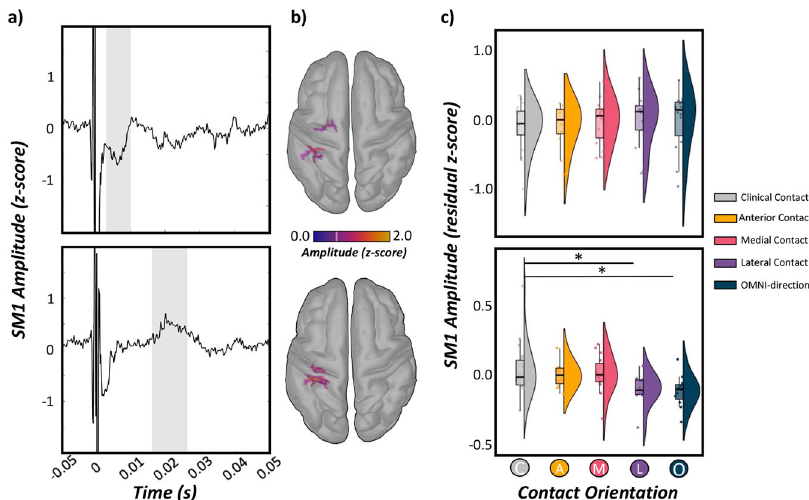
Fig. 2 Neural responses evoked by STN-DBS during different contact orientations. a Source reconstruction of DBS-evoked cortical responses was conducted using unconstrained weighted minimum norm estimation and revealed robust medium- and long-latency sensorimotor (SM1) responses ipsilateral to the site of stimulation from 3 – 10 ms (shaded gray bar; top panel) and 16 – 26 ms (shaded gray bar; bottom panel) following DBS pulses denoted at time 0 ms, respectively. Time-domain average of the extracted SM1 response (i.e., dominant orientation time series) with time (in ms) on the x -axis and response amplitude ( z -score) on the y -axis. All axes are fi xed for each graph. b Grand averaged cortical patterns of medium- (top panel) and long-latency (bottom panel) responses in the ipsilateral SM1 across all patients, trials and contact orientations. c LME of medium- and long-latency SM1 response amplitude (i.e., <10 ms and ~20 ms, respectively) as a function of contact orientation (factor with 5 levels), controlling for acquisition order and total electrical energy delivered revealed stronger SM1 long-latency responses when clinically-effective contact directions were applied, while medium-latency SM1 responses were unchanged. Raincloud plots include a combined box plot (box edges: fi rst 25th percentile quartile to third 75th percentile quartile; center line: median; data minima/maxima: whisker length), histogram distribution and individual scatter points of each evoked response. Signi fi cance is shown for post-hoc testing comparing optimal vs. all other non-optimal contact orientations at * p corrected <